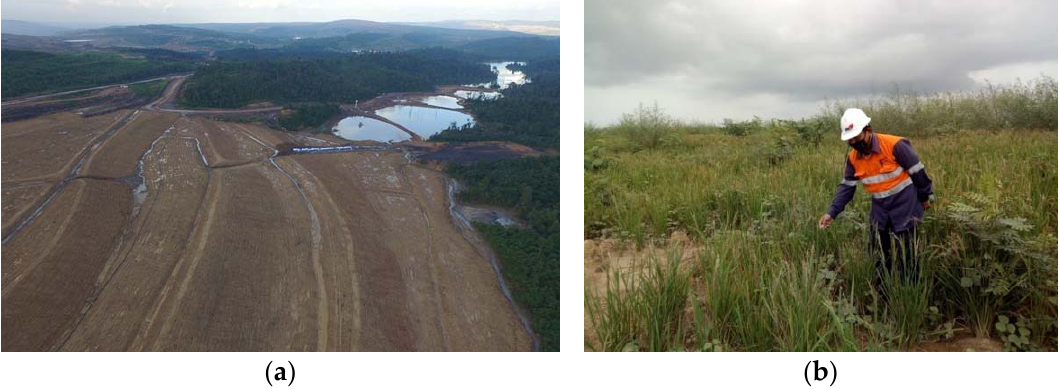
Figure 4. ( a ) The critical phase of the final surface against erosion and landslides after reclamation; ( b ) use of local upland rice and legumes as land cover crops to reduce the risk of erosion. Photo by Kaltim Prima Coal.